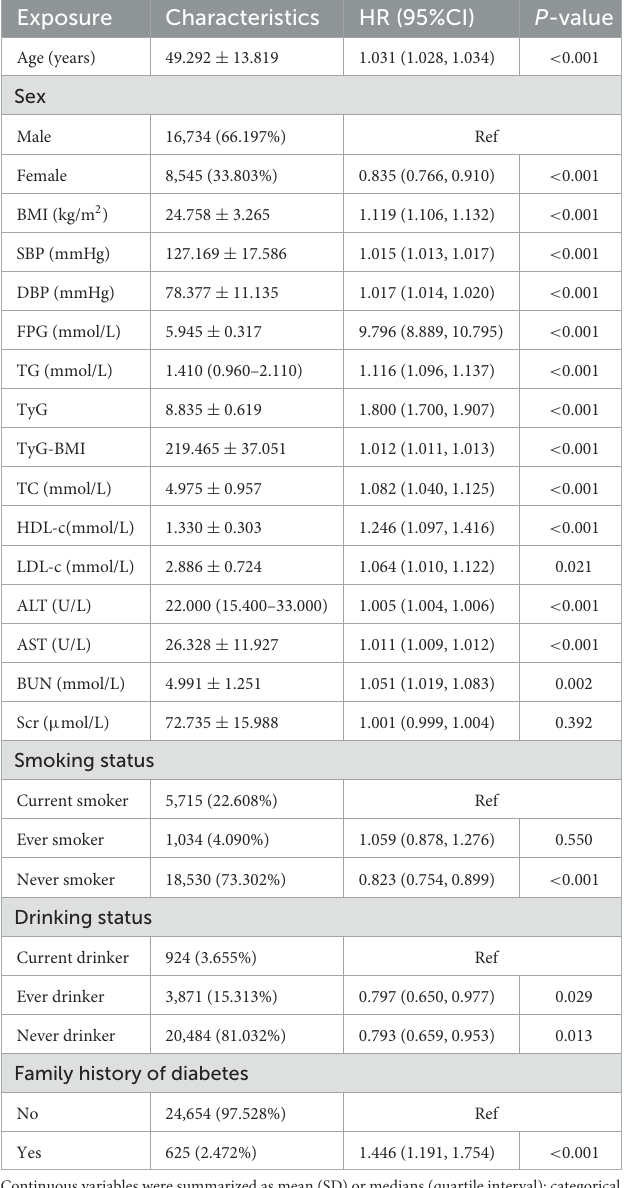
TABLE 3 Factors influencing the risk of diabetes in patients with prediabetes analyzed by univariate Cox proportional hazards regression. Exposure